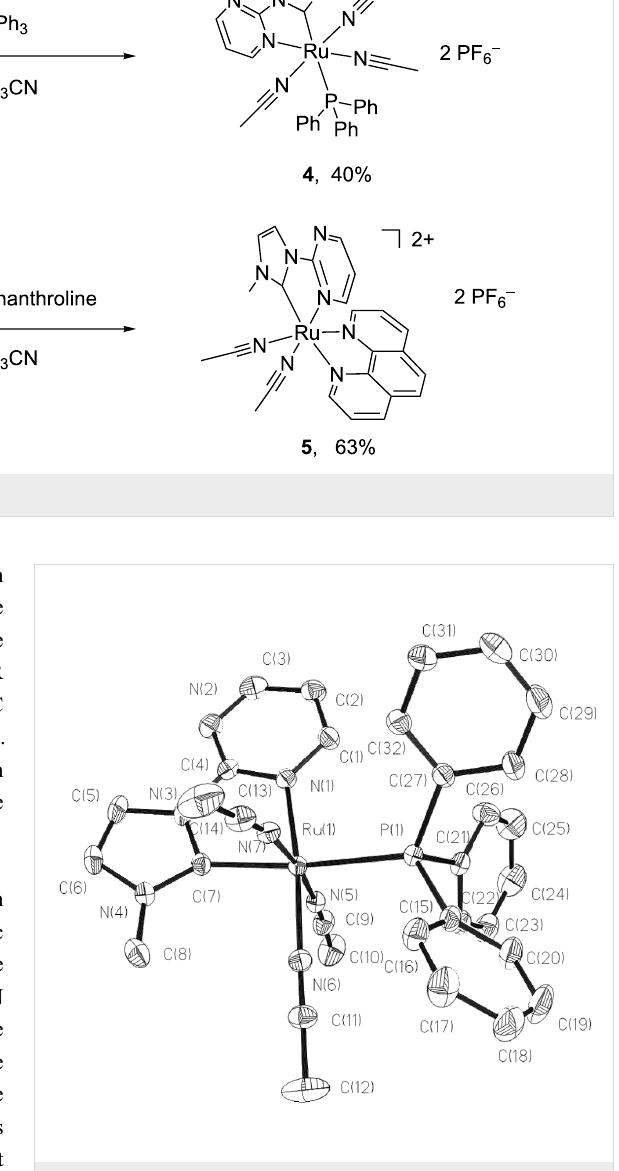
Figure 4: Structural view of 4 showing 30% thermal ellipsoids. All hydrogen atoms and PF 6 − were omitted for clarity. Selected bond lengths (Å) and angles (deg): Ru(1)–N(5) 2.012(4), Ru(1)–N(7) 2.020(4), Ru(1)–N(6) 2.025(4), Ru(1)–C(7) 2.039(4), Ru(1)–N(1) 2.120(4), Ru(1)–P(1) 2.4080(11), N(5)–Ru(1)–N(7) 173.83(16), N(5)–Ru(1)–N(6) 87.01(16), N(7)–Ru(1)–N(6)